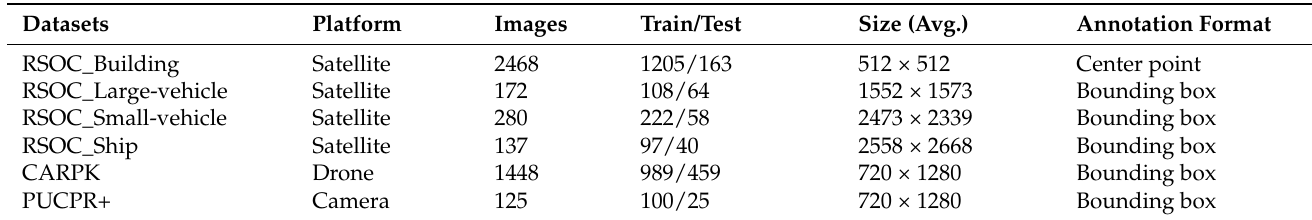
Table 1. Detailed information of the RSOC, CARPK and PUCPR+